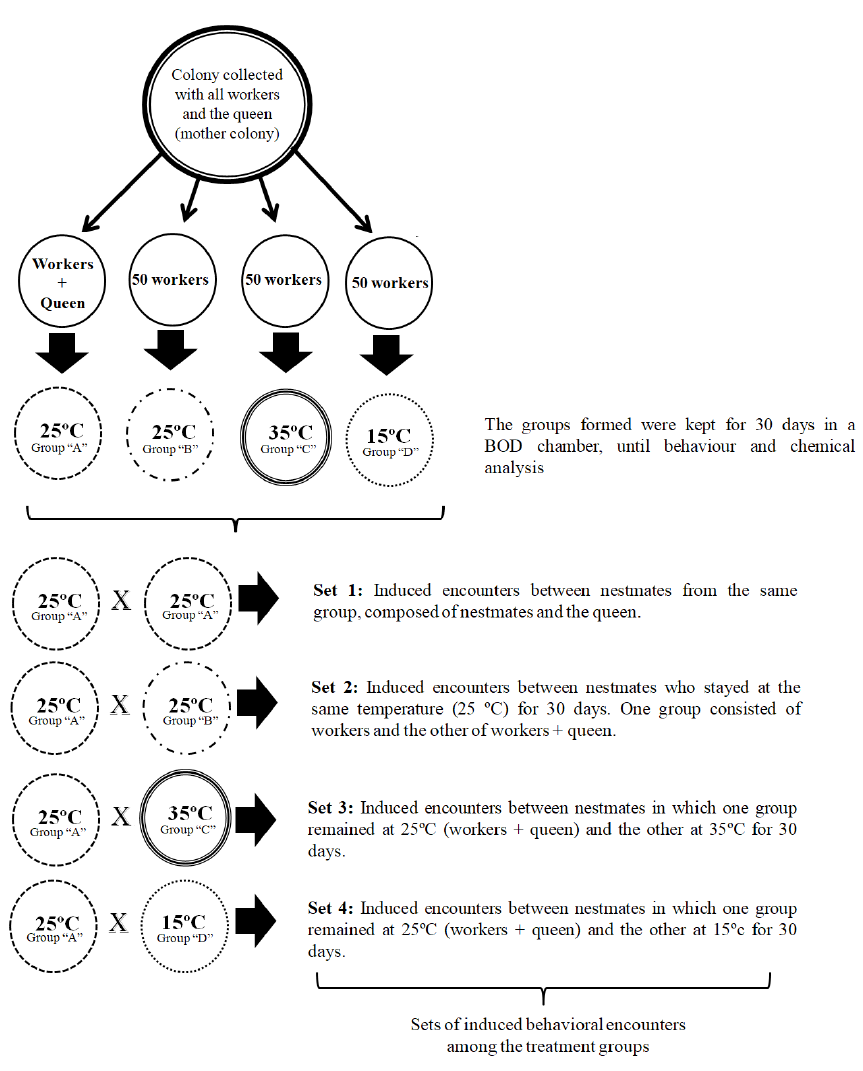
Fig 1. Sample design showing how the groups of ants were formed from the mother colony, together with the corresponding temperatures at which the workers were maintained prior to the induced